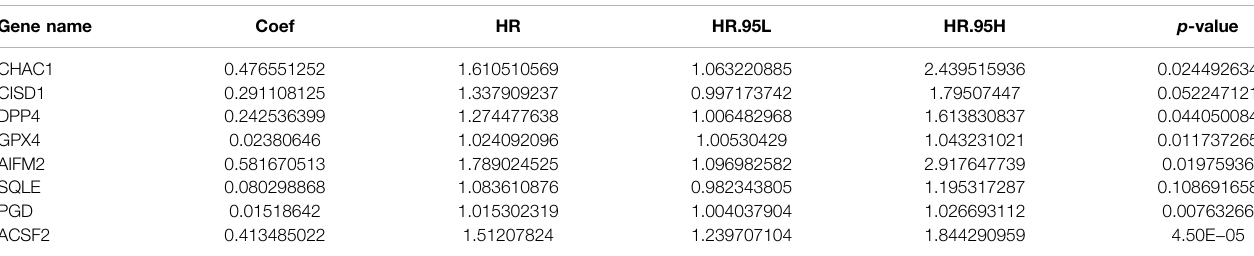
TABLE 3 | Multivariate Cox regression analysis of model genes in the TCGA-LAML